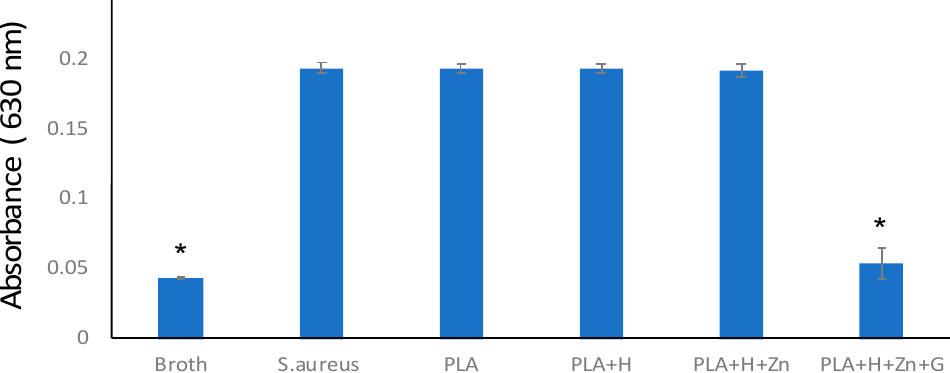
Figure 8. Bacterial growth inhibition. Broth without any samples or bacterial were set as the negative control (broth). S. aureus culture in broth was set as the positive control ( S. aureus ). The same amount of S. aureus suspension was co-cultured with a scaffold composed by PLA, PLA added with HNTs (PLA+H), PLA added with zinc-loaded HNTs (PLA+H+Zn), and PLA added with zinc-loaded HNTs and coated with gentamicin (PLA+H+Zn+G), (error bar with standard deviation, n = 3, * p < 0.05).